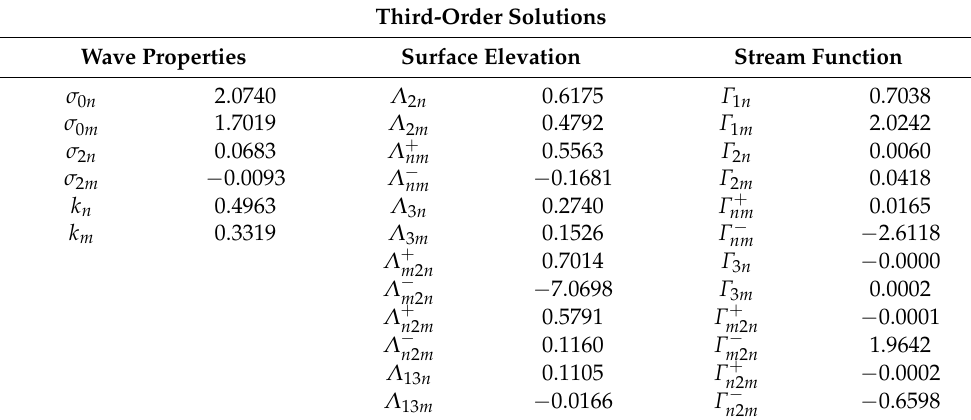
Figure 2. An example of the third-order surface elevation solution for a bichromatic wave on linear shear current at t = 0 and the horizontal velocity profile solution for a bichromatic wave on linear shear current at t = 0, x = 0. Table 1. Relevant coefficients for the third-order example.